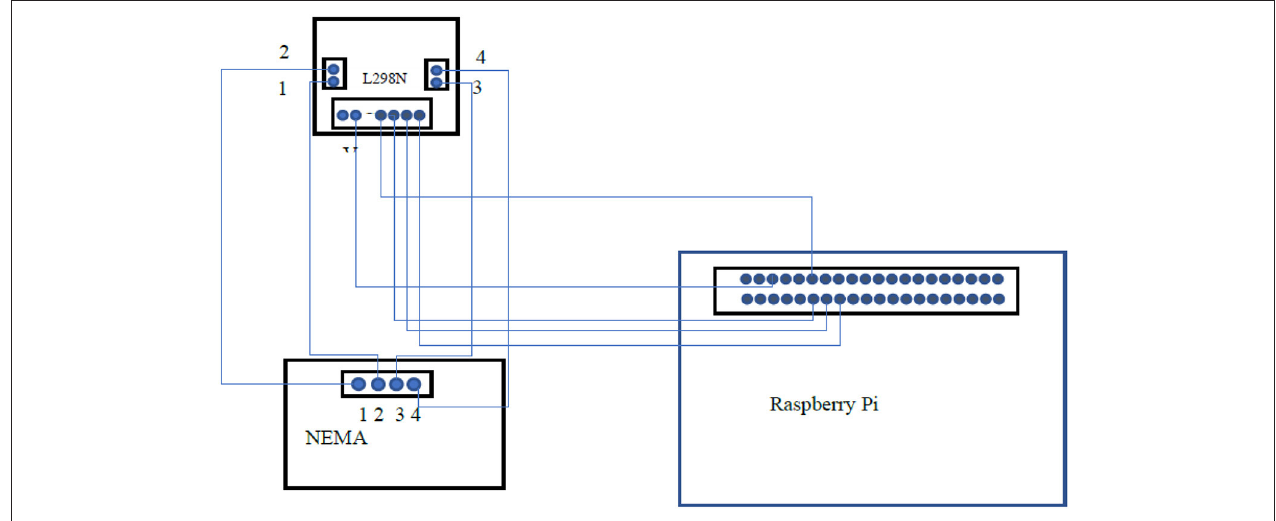
FIGURE 7 | Interfacing of NEMA 17 stepper motor with Raspberry Pi.